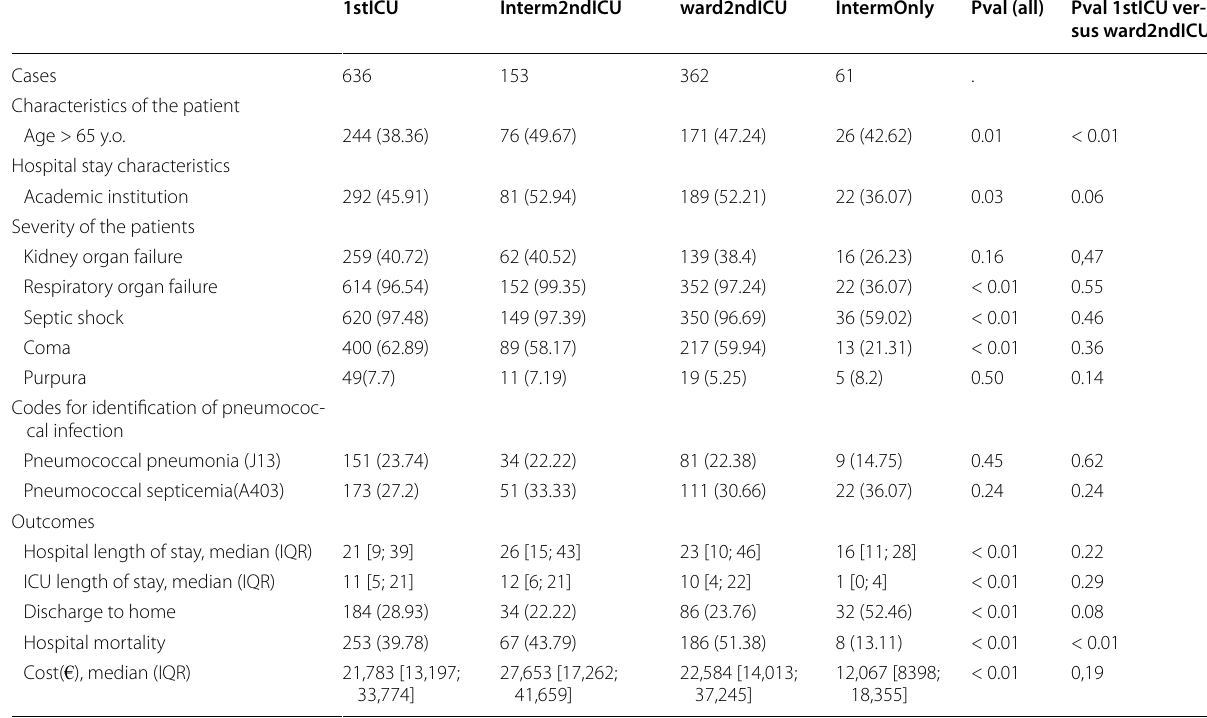
Table 1 Comparison of the care paths of Pneumococcal Meningitis with sepsis in